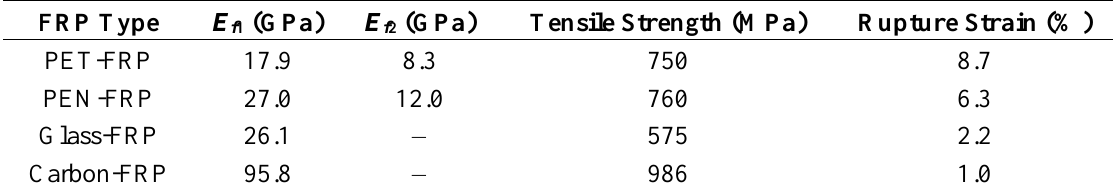
Table 2. Material properties of FRP composites (part of this reproduced after Dai et al. [13], copyright 2011